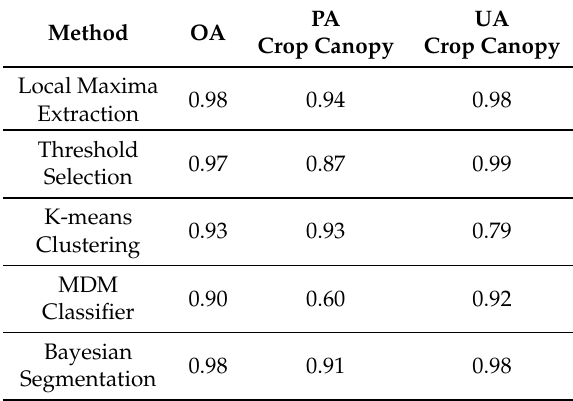
Figure 10. Tomato field site: crop row detection results for ( a ) local maxima extraction, ( b ) threshold selection, K-means clustering ( c ), MDM classifier ( d ), and Bayesian segmentation ( e ). Figures refer to the area included in the red box in ( f ). Table 10. Tomato field site: assessment of the best results of each detection